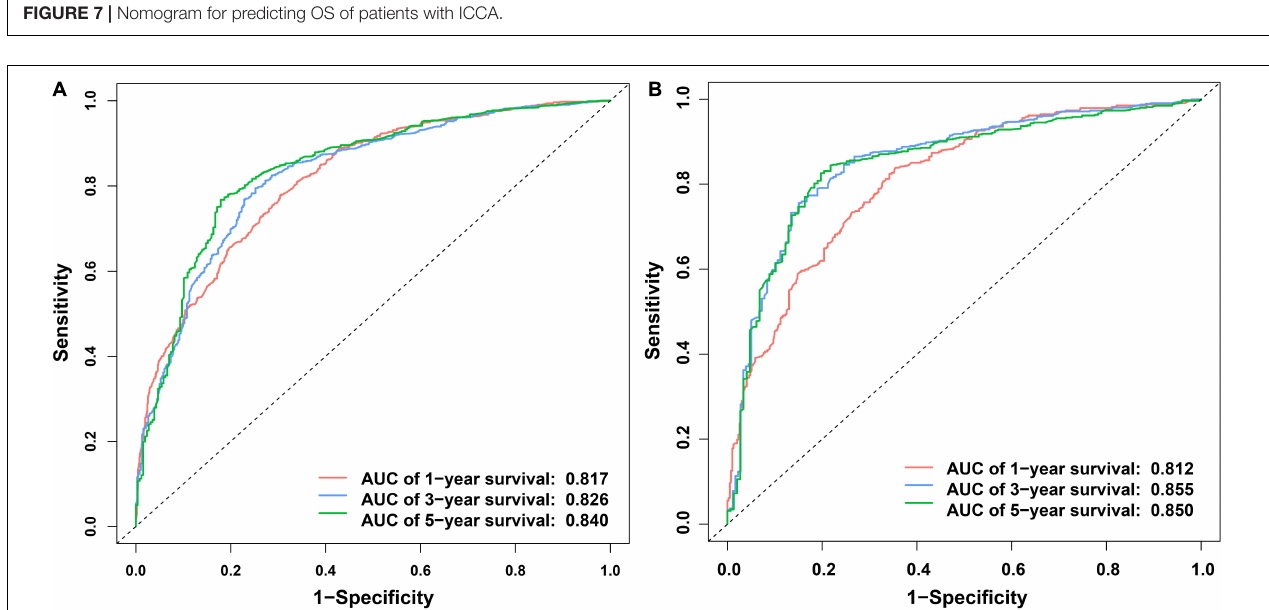
FIGURE 8 | ROC curves of the nomogram. (A) ROC curves of the 1-, 3-, and 5- OS in the training dataset. (B) ROC curves of the 1-, 3-, and 5-year OS in the testing